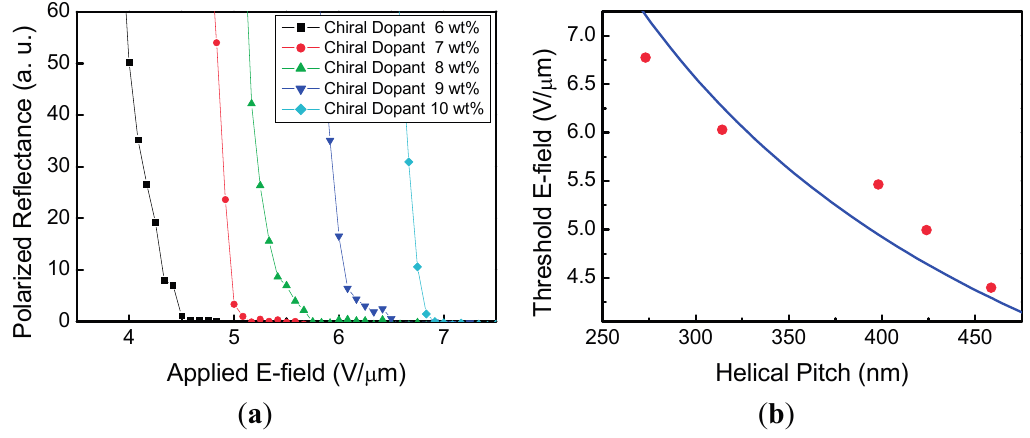
Figure 5. Dependence of the electro-optic response on the chiral dopant concentration of the samples before polymerization. ( a ) Polarized reflection intensity integrated over the wavelength 480–730 nm with respect to the applied electric field at different chiral dopant concentrations; ( b ) Threshold electric field with respect to the helical pitch. The red solid circles are measured results and blue curve is the fitting curve.